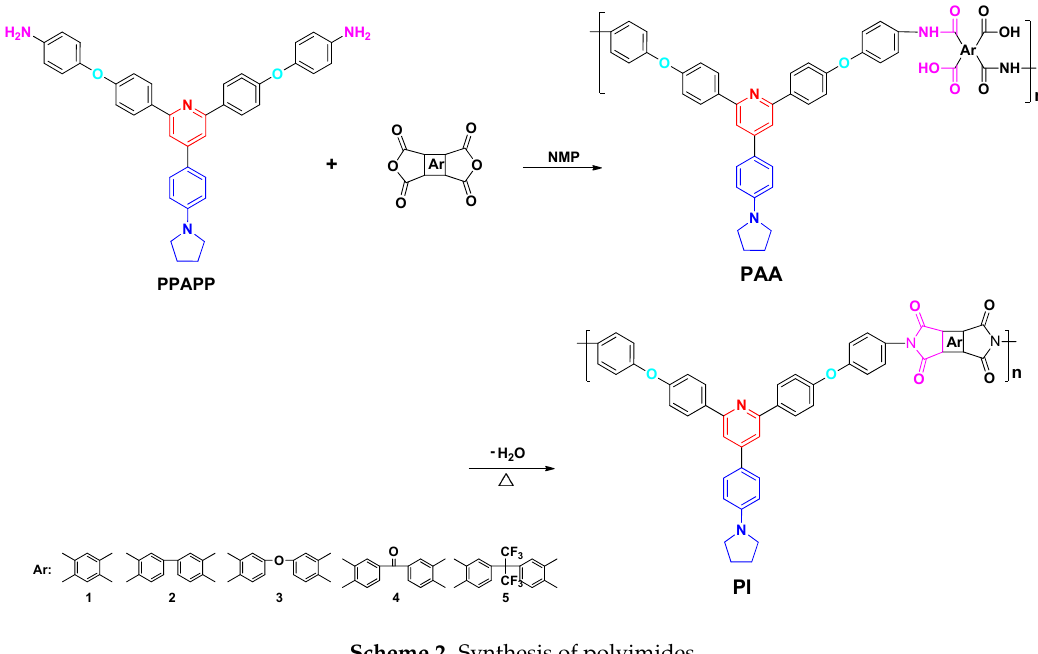
Scheme 2. Synthesis of polyimides.